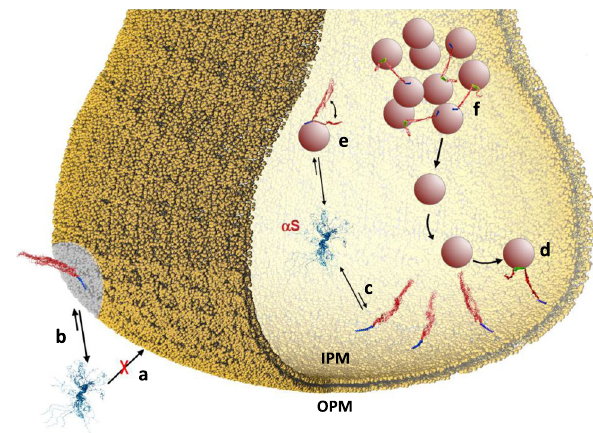
Fig. 4 Membrane traf fi cking of α S at the synaptic termini. Schematic illustration of the different interactions between α S and biological membranes at the synaptic termini. a α S binds to OPM with negligible af fi nity. b When the content of GMs in the membrane composition increases, such as in the case of some neurodegenerative disorders 52 and in lipid rafts 54,65 , the af fi nity of α S for OPM is considerably enhanced. c The binding af fi nity of α S for IPM is signi fi cantly higher than that observed in the case of OPM. Upon interaction with IPM, α S adopts a conformation where only the N-terminal anchor (blue) is tightly bound to the membrane, with the region of residues 65 – 140 (red) having negligible association with the membrane surface. d This peculiar conformation has signi fi cant propensity to promote a double-anchor mechanism (N-terminal anchor in blue; second anchor spanning residues 65 – 97 in green) that stabilises the SV docking onto the IPM surface in an α S concentration-dependent manner. The IPM binding by α S competes with the binding to SVs ( e ), which is involved in the mainteinance of pools of vesicles ( f ) from which SVs diffuse toward the active